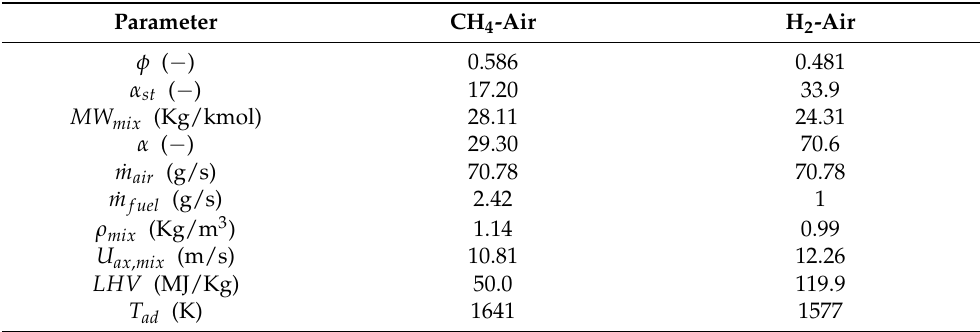
Table 1. Comparison of the main parameters characterizing the two mixtures employed in this work: CH 4 –air and H 2